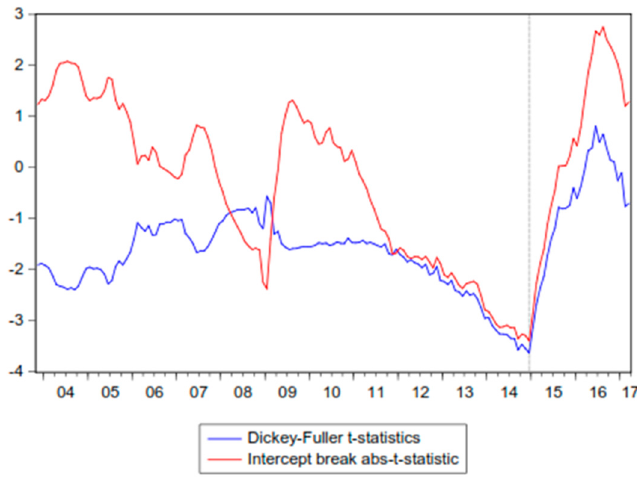
Figure 3. VP test breakpoint estimation over t θ and Dickey–Fuller (DF) t -statistic. Notes: x -axis denotes years and y -axis denotes t-statistic value.